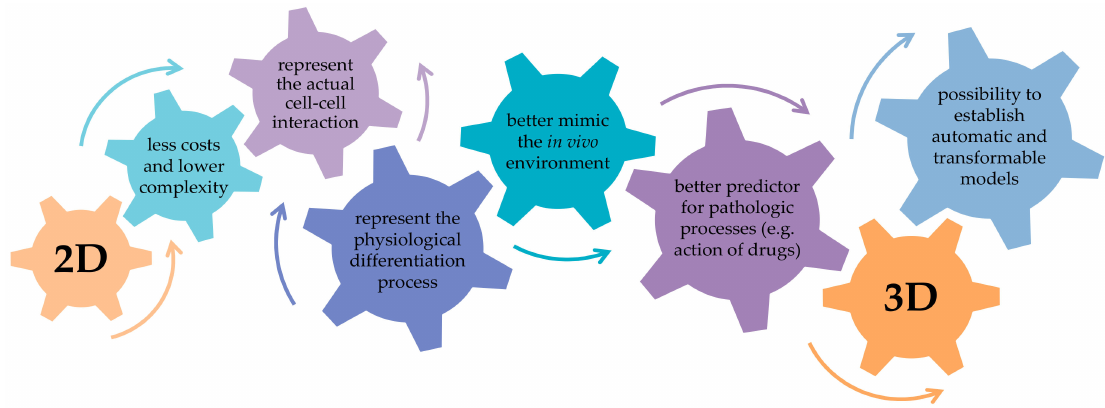
Figure 2. Conventional 2D cultures convince with a simple handling and a large variety of analytical methods available. However, by introducing co-cultures of cells into a 3D environment, functionality of the cells can be significantly improved, as it better mimics the in vivo situation. Further dynamization, e.g., perfusion or application of mechanical loads, can be included considering that with increasing complexity of the system, the use of established analytical methods becomes